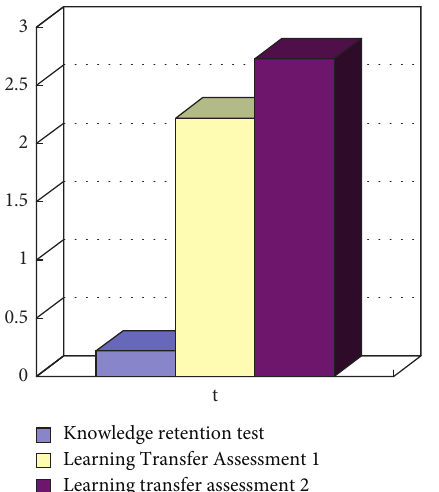
Figure 9: Independent sample T test results of knowledge retention test and learning transfer assessment results.